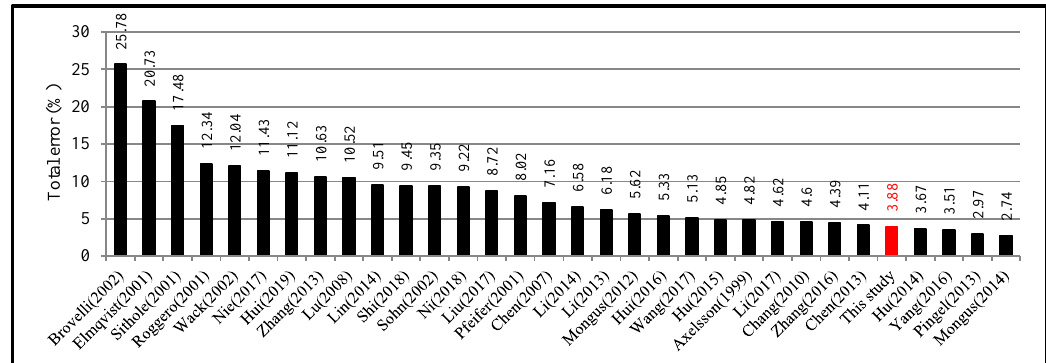
Figure 14. Total error average on 15 samples for 32 filters, in which CR value in the proposed algorithm is set to 0.5 m. The proposed algorithm is marked in red.